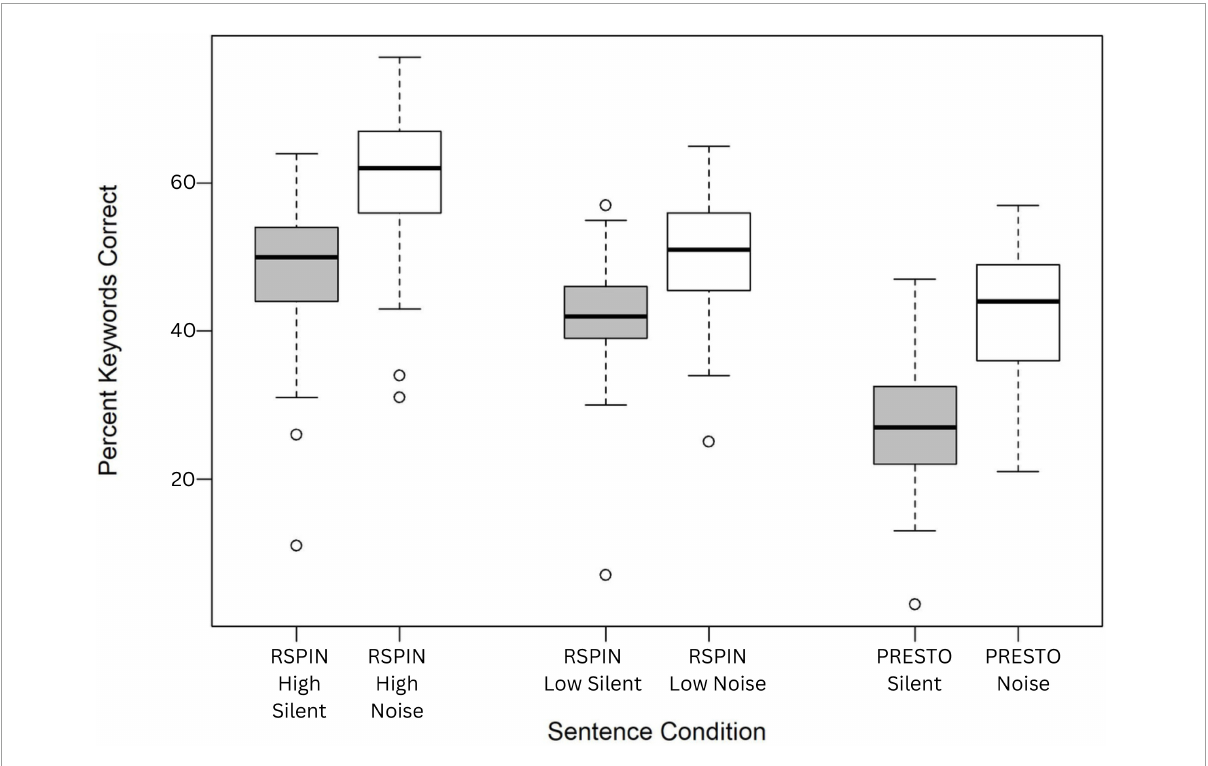
FIGURE1 Box plot representing perceptual restoration, or the percent of keywords correctly identified for the six sentence conditions.